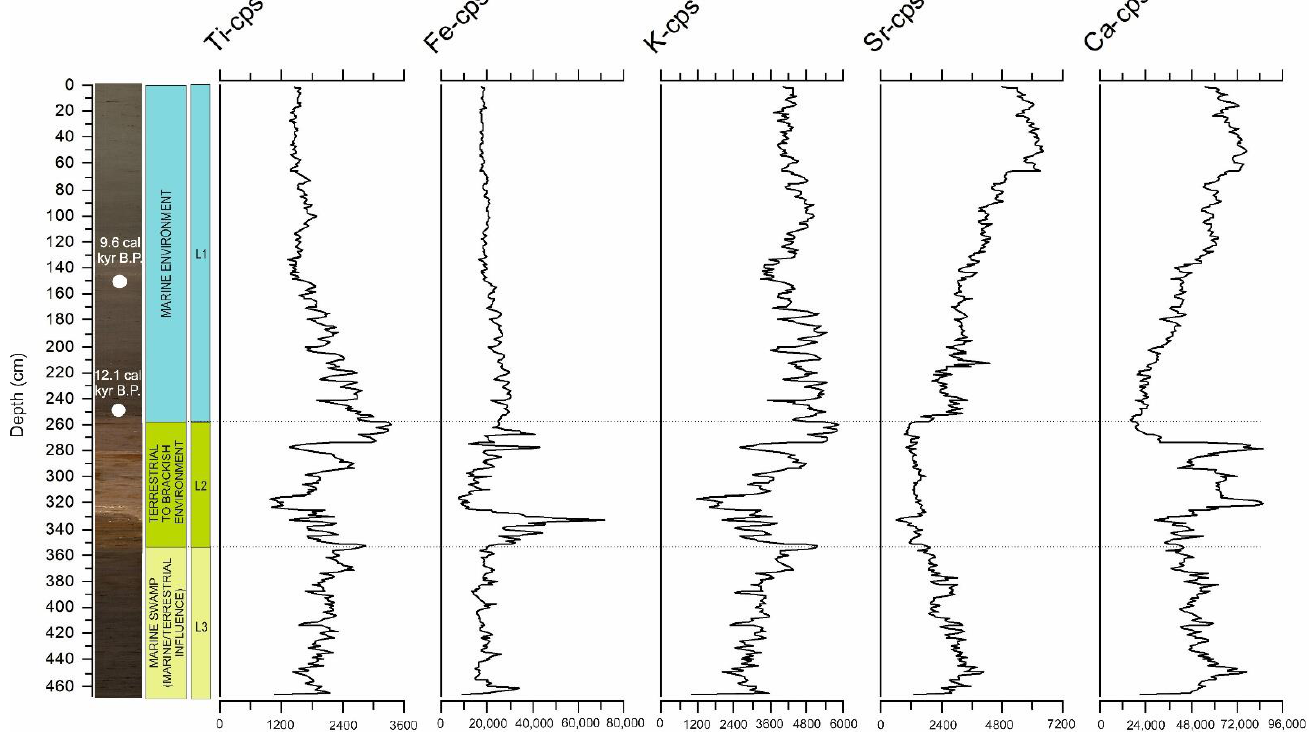
Figure 10. Sediment core KK-1 and lithological units with Ti, Fe, K, Sr, and Ca variation.